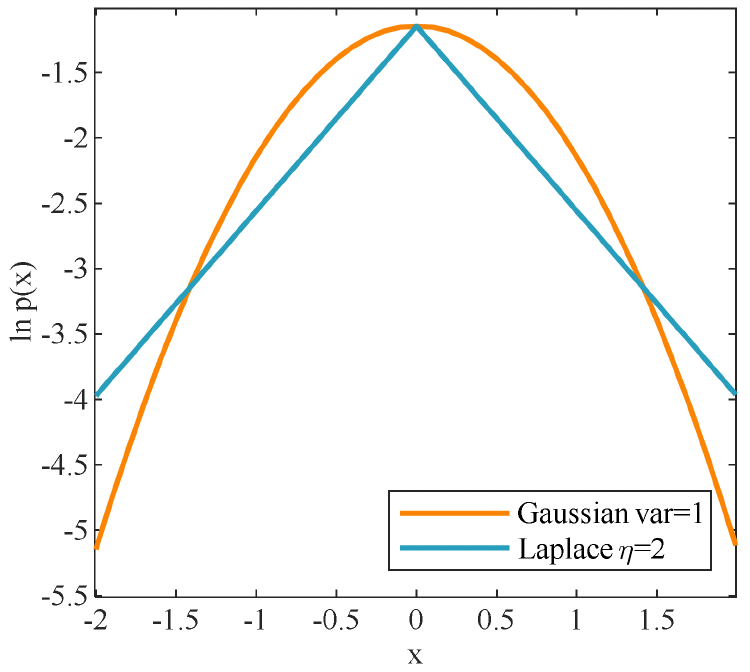
Figure 3. Gaussian and Laplace